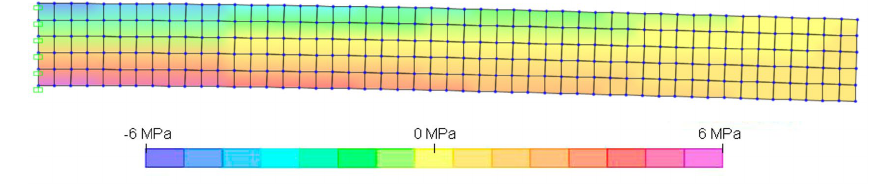
Figure 8. Beam stress distribution via FEM